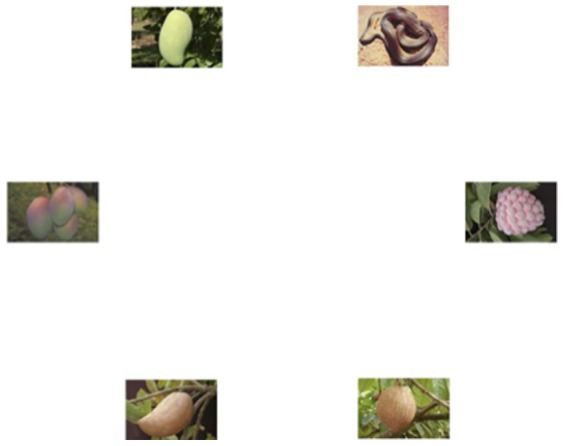
Example of the circular stimuli display (set size 6) used in Exp. 1 and 3.